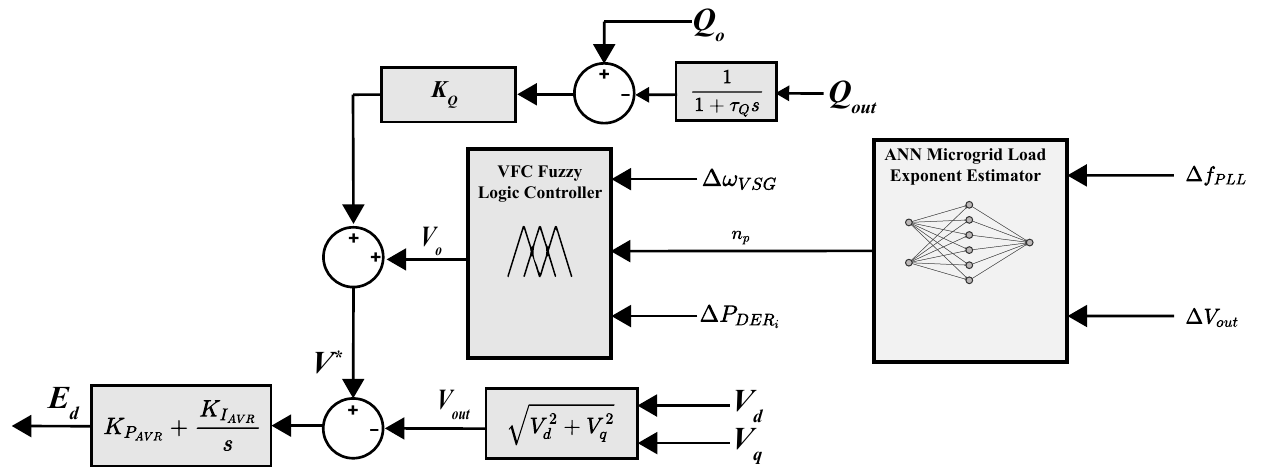
Figure 4. Proposed decentralized fuzzy logic based voltage–frequency control (VFC).